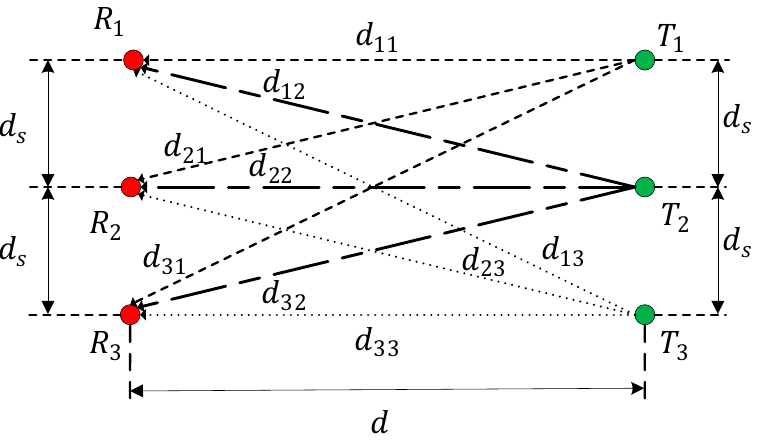
Figure 6. Rectangular 3 × 3 transceiver antenna array.